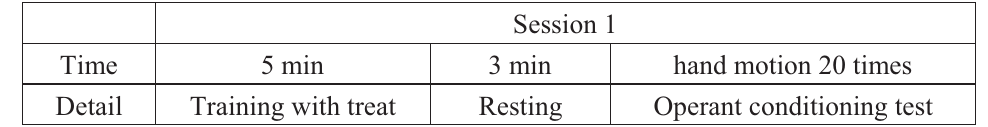
Table 2. The daily training schedule.